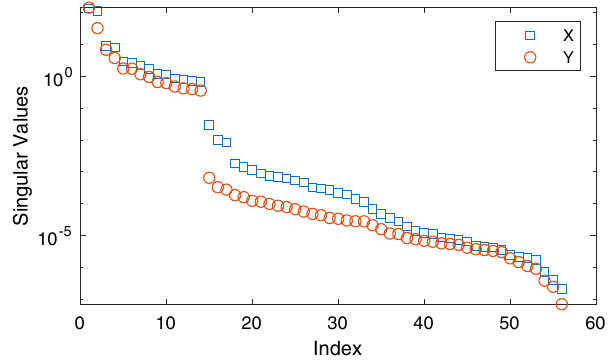
FIG. 8. The singular values of the horizontal and vertical response matrices of the IOS by the 14 QF magnets (with a scale change of þ 2% or − 2% of alternating signs) with respect to the correctors.